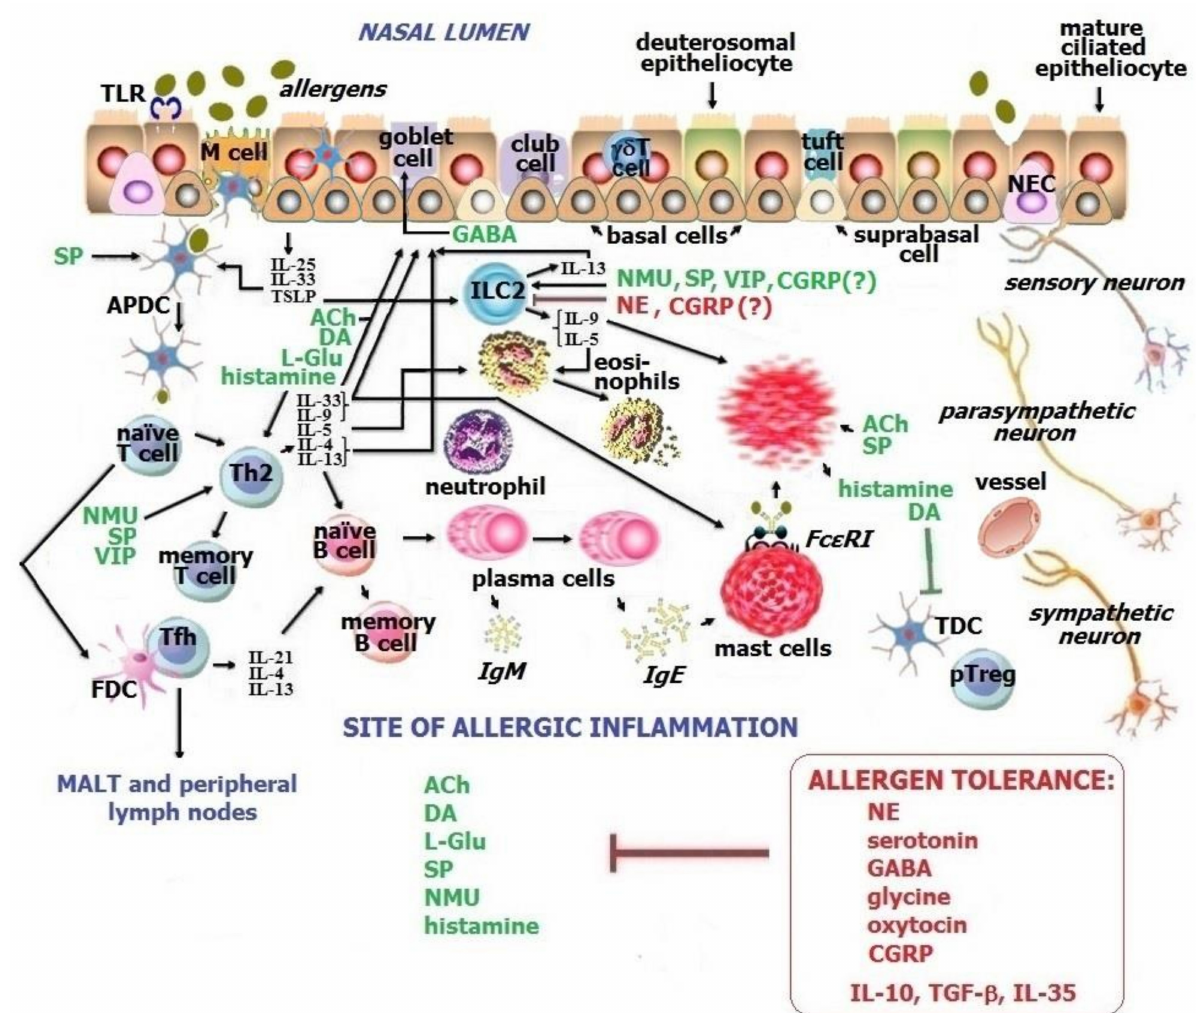
Figure 2. Neuro molecules’ effects in allergic inflammation in the nose. Neurotransmitters and neuropeptides display different effects if allergen tolerance breakdown occurs. ACh and, para- doxically, GABA stimulate the goblet cells to produce mucus. Many neuro molecules, e.g., ACh, DA, L-Glu, histamine, NMU, SP, and VIP, upregulate the Th2-mediated immune response and Th2- associated allergic inflammation. In addition, NMU, SP, and VIP activate ILC2, but NE inhibits the activation of these cells. ACh and SP promote the degranulation of mast cells, DA and histamine downregulate pTregs. CGRP is reported to exert controversial effects. Therefore, pro-immunogenic neuro molecules are predominant in allergic inflammation. ACh—acetylcholine, DA—dopamine, L-Glu—L-glutamate, SP—substance P, NMU—neuromedin U, NE—norepinephrine, GABA— γ Aminobutiric acid, VIP—vasoactive intestinal peptide, CGRP—calcitonin-gene-related peptide, APDC—allergen-presenting dendritic cell, FDC—follicular dendritic cell, TDC—tolerogenic dendritic cell, ILC2—group 2 innate lymphoid cell, Th2—type 2 helper T cell, Tfh—follicular helper T cell, pTreg—peripheral regulatory T cell, M cell—“microfold” cell, TLR—Toll-like receptors, Fc ε RI—type I IgE receptor, TGF- β —transforming growth factor- β , MALT—mucosae-associated lymphoid tissue. Pro-immunogenic action is noted in green, and protolerogenic action is noted in